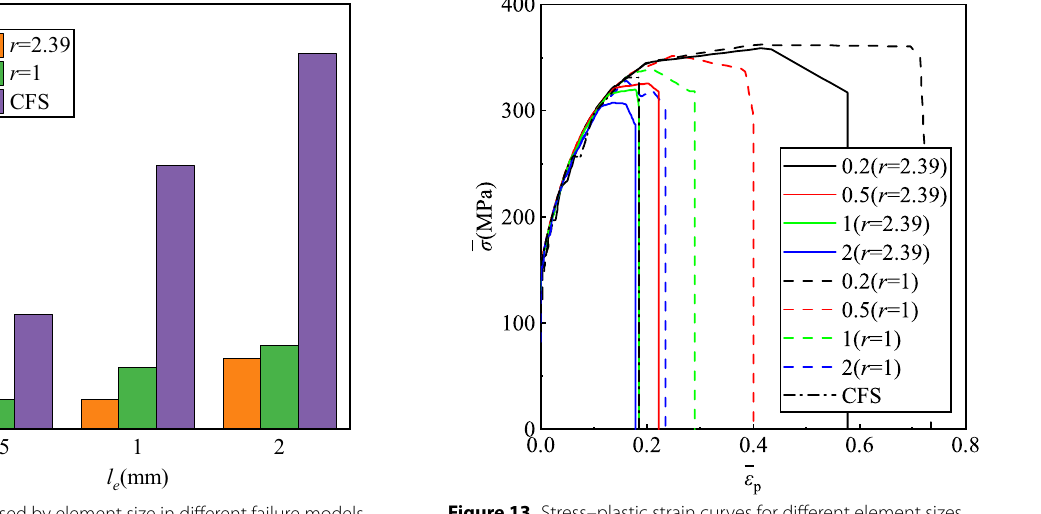
Figure 12 Errors caused by element size in different failure models Figure 13 Stress–plastic strain curves for different element